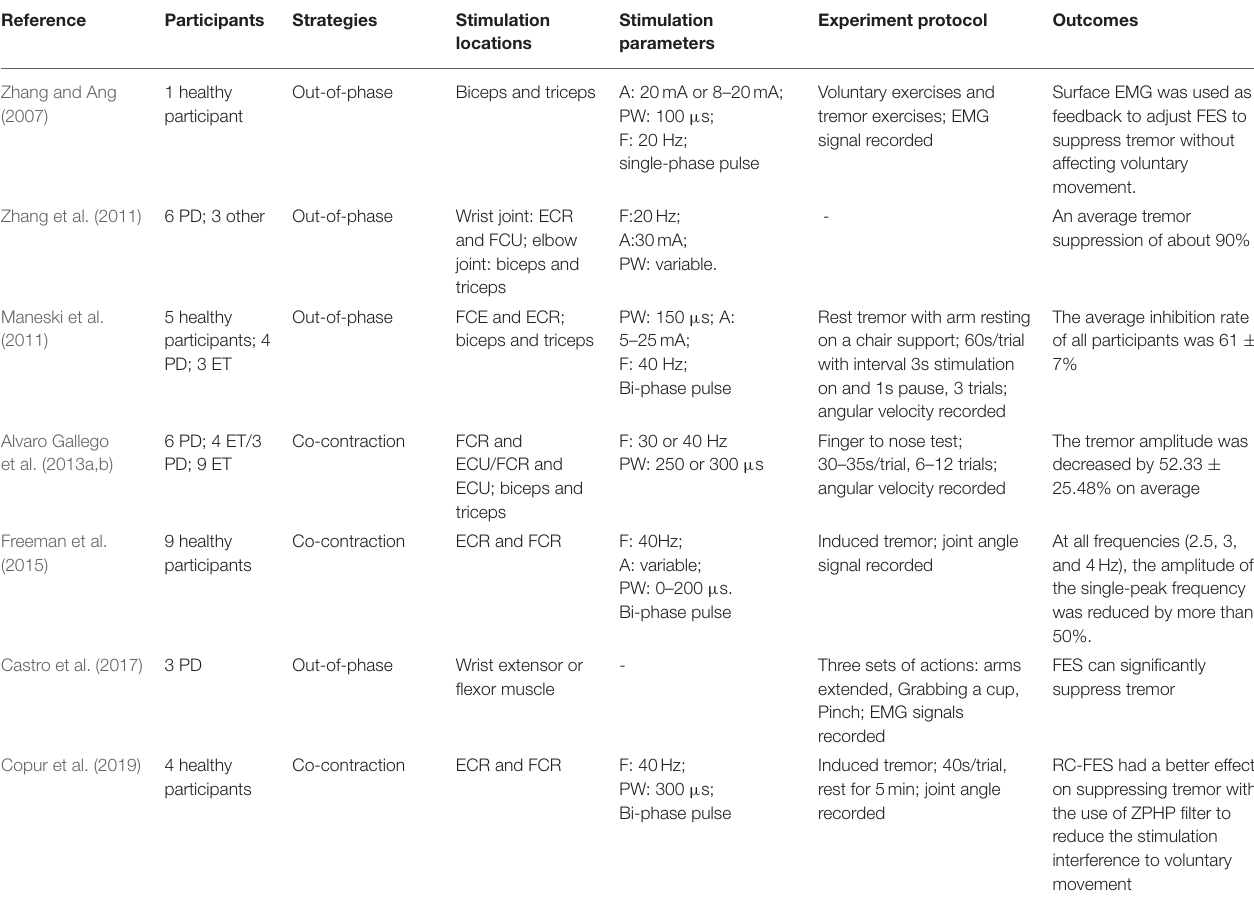
TABLE 1 | Summary of the methodologies and outcomes of functional electrical stimulation (FES).